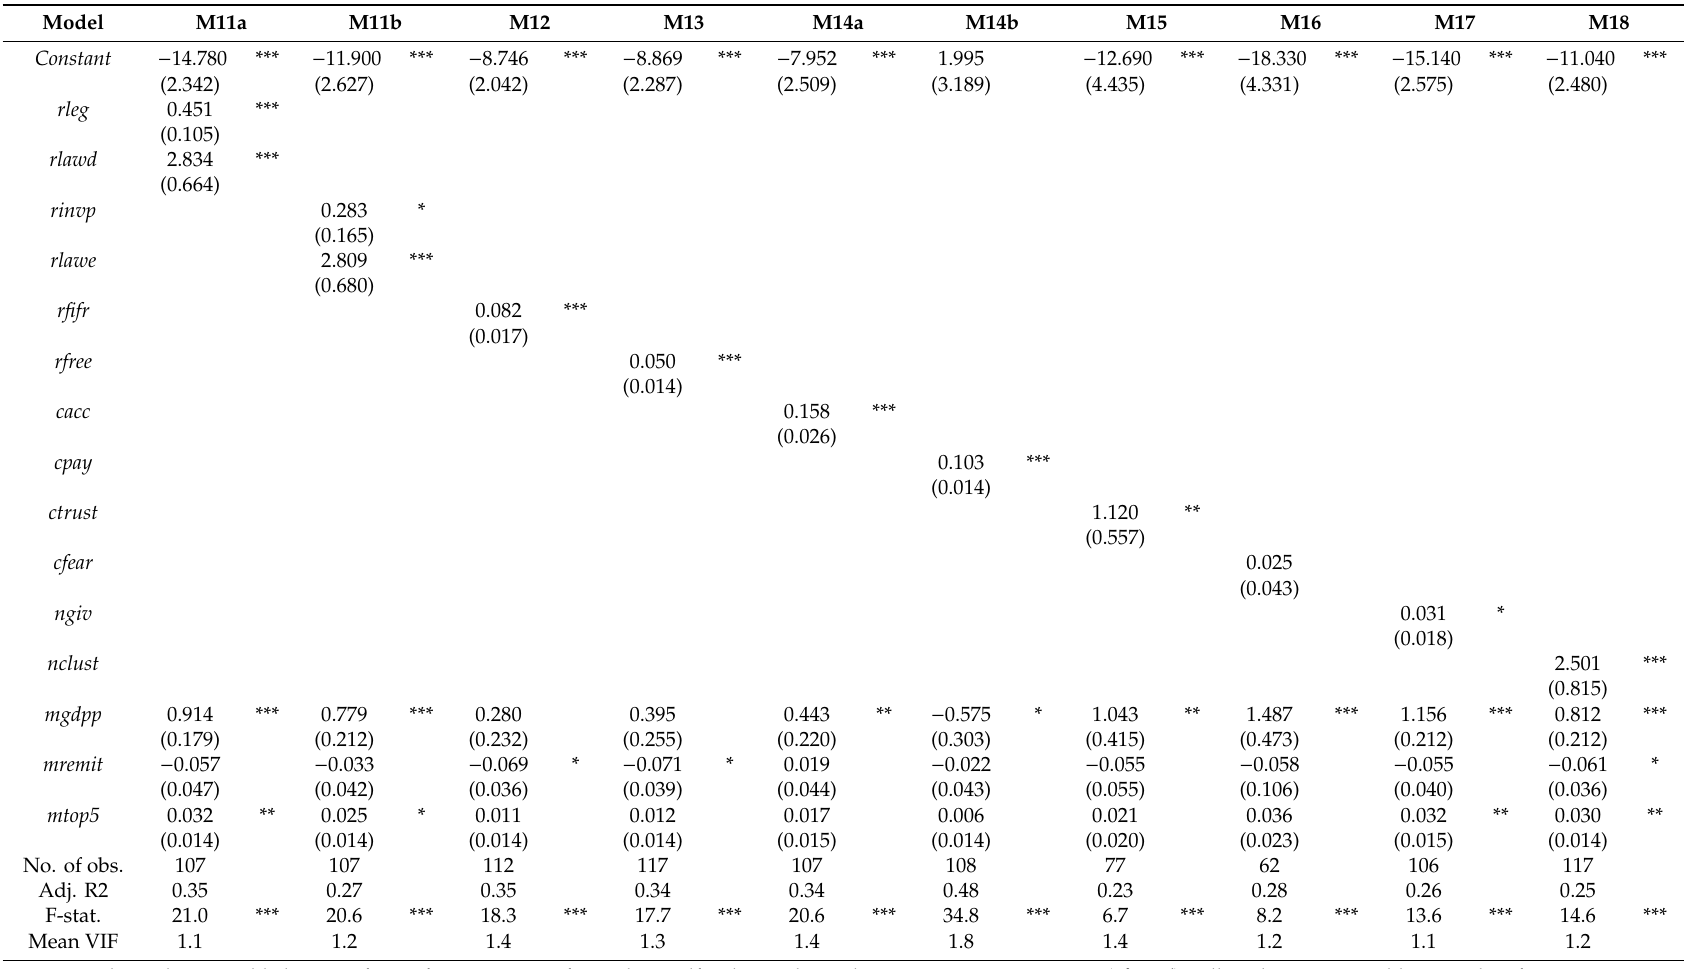
Table A4. Robustness of Regulative, Cultural-Cognitive, and Normative Determinants of Total Crowdfunding Volumes during 2015–2016 per Capita. Model